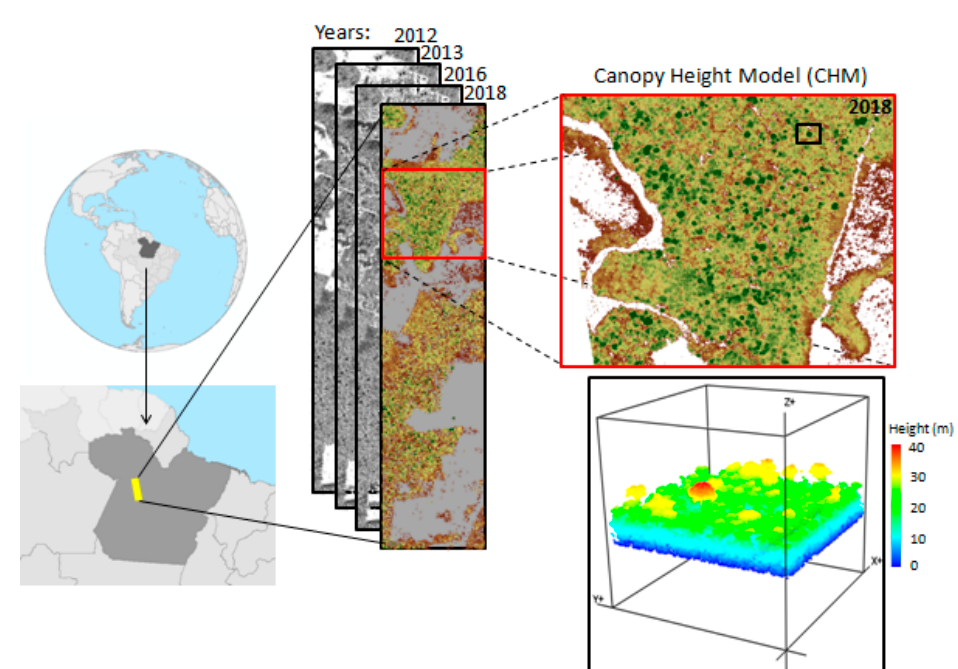
Figure 1. Location of the study area in the Pará state, Brazil and the multi-temporal Light Detection and Ranging (LiDAR) flights (left). The inset presents a zoom on the Canopy Height Model (CHM) for 2018, showing the distribution and spatial variation in terms of canopy height across the human-modified tropical forest (HMTF). Below the inset, a sample of a three-dimension image of the CHM is shown.